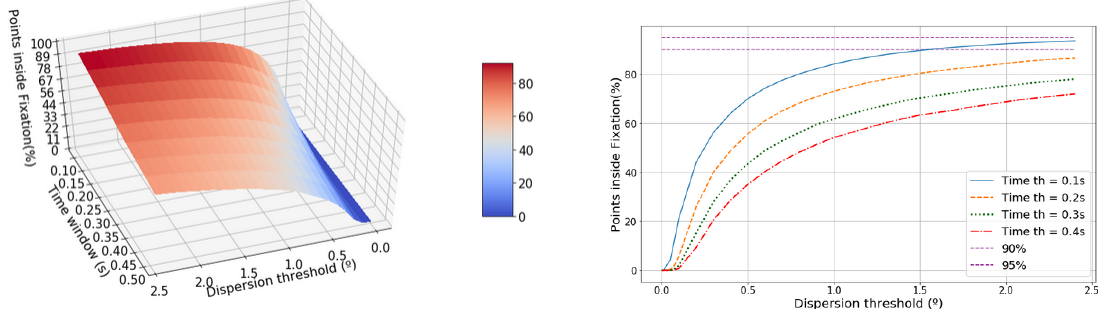
Figure 5. The left-hand graphic shows the evolution of the percentage of points classified as a part of a fixation in terms of the dispersion threshold and the time window. The right-hand graphic shows the projected dispersion threshold.